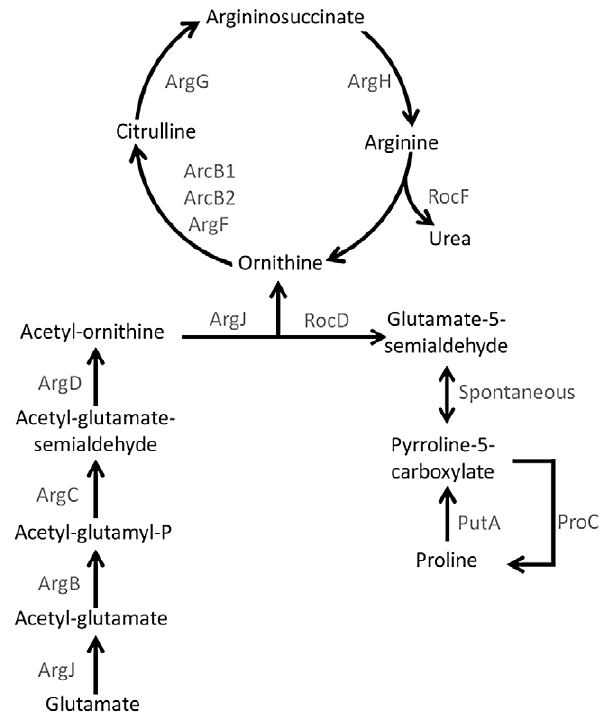
Figure 3. Arginine biosynthetic pathway via glutamate and proline. Figure depicts highly conserved arginine biosynthetic pathway via glutamate and the proposed pathway from proline via PutA, RocD, ArcB1, ArgG and ArgH. Note the previously established reverse pathway from arginine to proline via RocF, RocD and ProC.